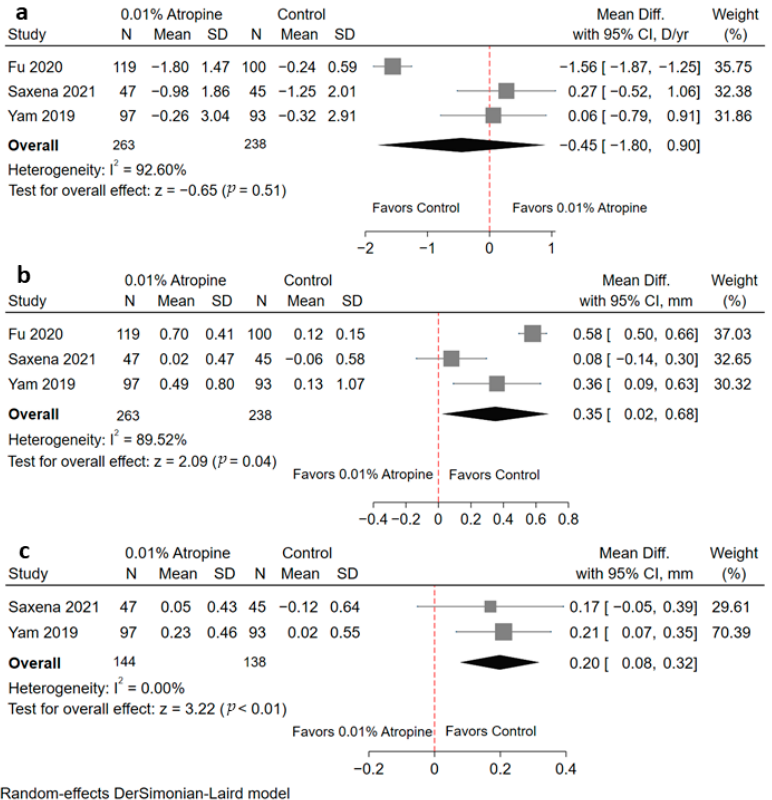
Figure 3. Forest plot of safety profiles between the 0.01% atropine and control groups; ( a ) change in accommodative amplitude, ( b ) change in photopic pupil diameter, ( c ) change in mesopic pupil diameter. Diff, difference; SD, standard deviation; CI, confidence interval; D, diopter; yr, year.